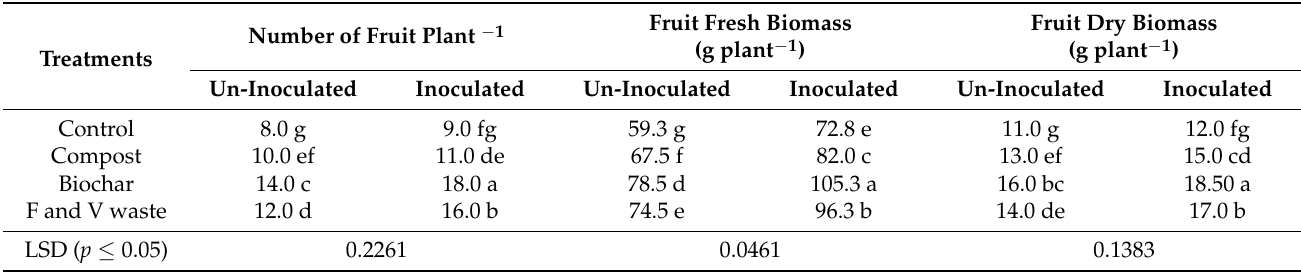
Table 6. Effect of compost, biochar, fruit and vegetable waste (F and V waste) and Bacillus subtilis SMBL 1 on number of fruit plant − 1 and fruit fresh and dry biomass of okra. Number of Fruit Plant − 1 Treatments